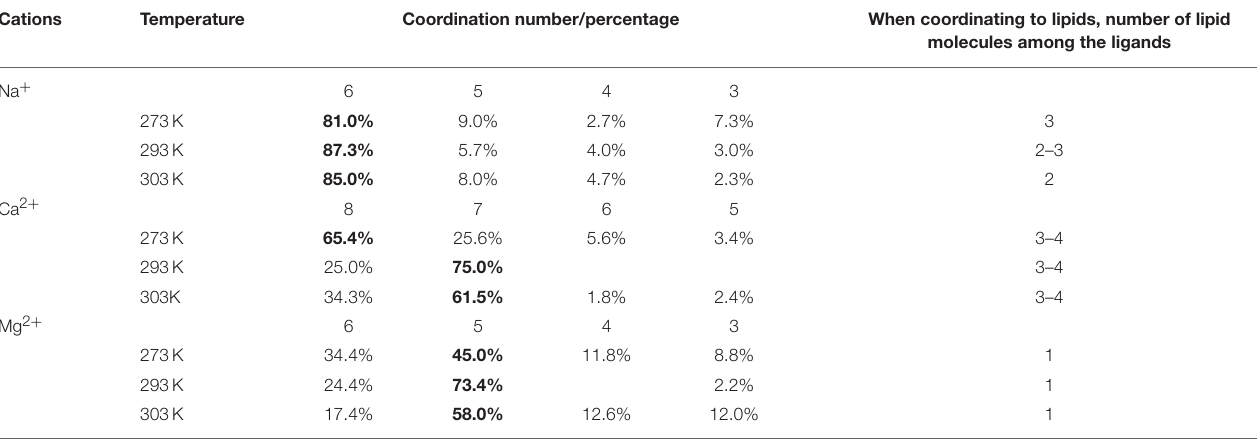
TABLE 1 | Quantitative analysis of the chemical environments of the metal ions in the computational results. Cations Temperature Coordination